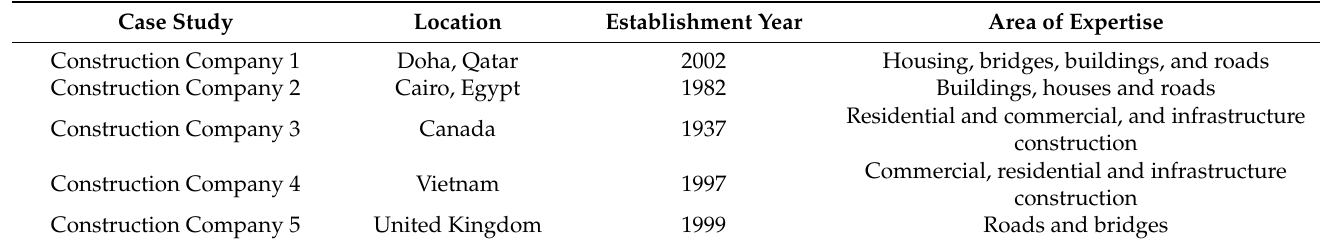
Table 2. Description of the five case studies.